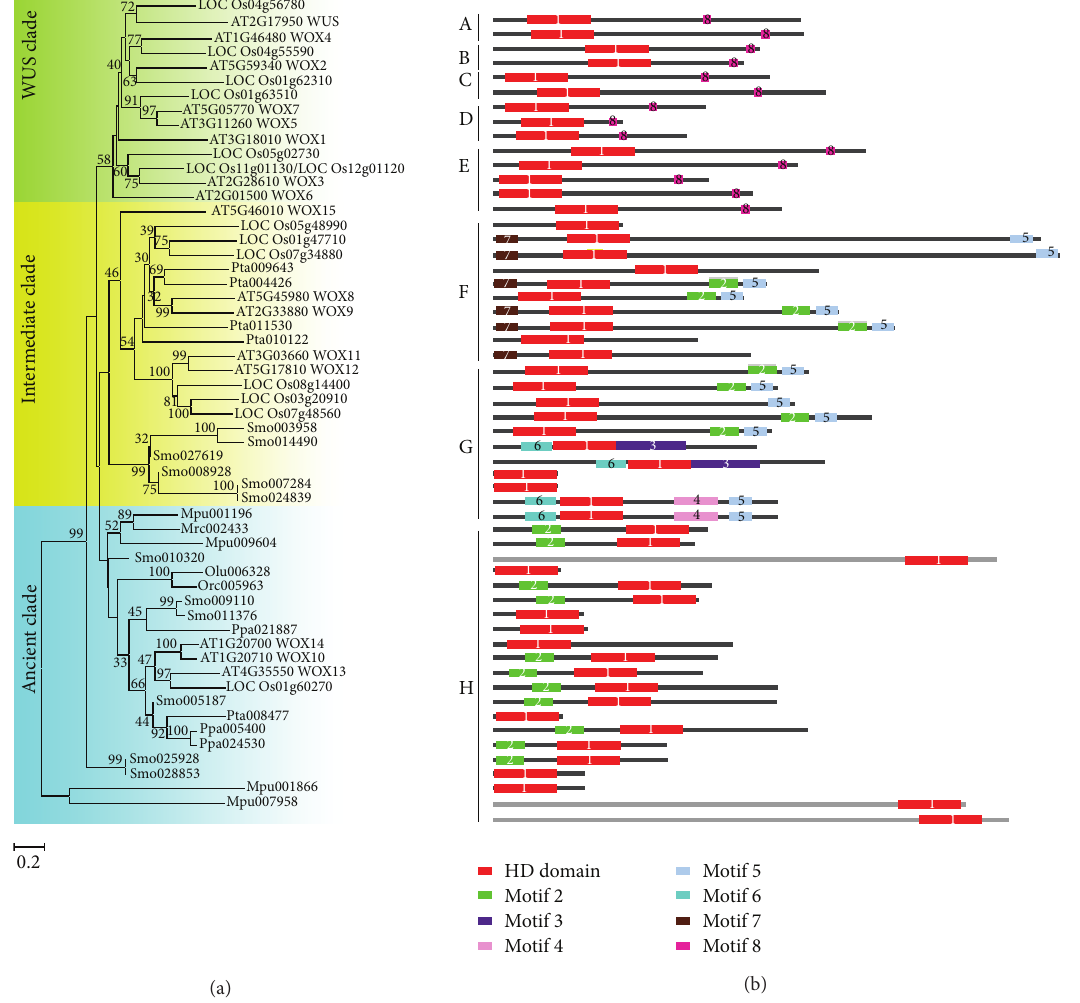
Figure 5: Phylogenetic tree of WOX family and motif analysis in model plants. (a) The phylogenetic tree (NJ) was constructed by MAGE 4 (Kumar et al., 2004) using 56 sequences from green algae ( Micromonas , Ostreococcus tauri , and Ostreococcus lucimarinus ), Physcomitrella patens (Ppa), Selaginella moellendorffii (Smo), Pinus taeda (Pta), Oryza sativa (Os), and Arabidopsis thaliana (At). WUS clade, intermediate clade, and ancient clade are color-coded green, orange, and blue, respectively. The WUS clade contains members only from angiosperms; the intermediate clade contains members only from vascular plants; the ancient clade contains members from lower plants to higher plants. (b) The conserved motifs among the members are highlighted in colored boxes with an arranged number and the sequences of the motifs are listed in Supplementary Table